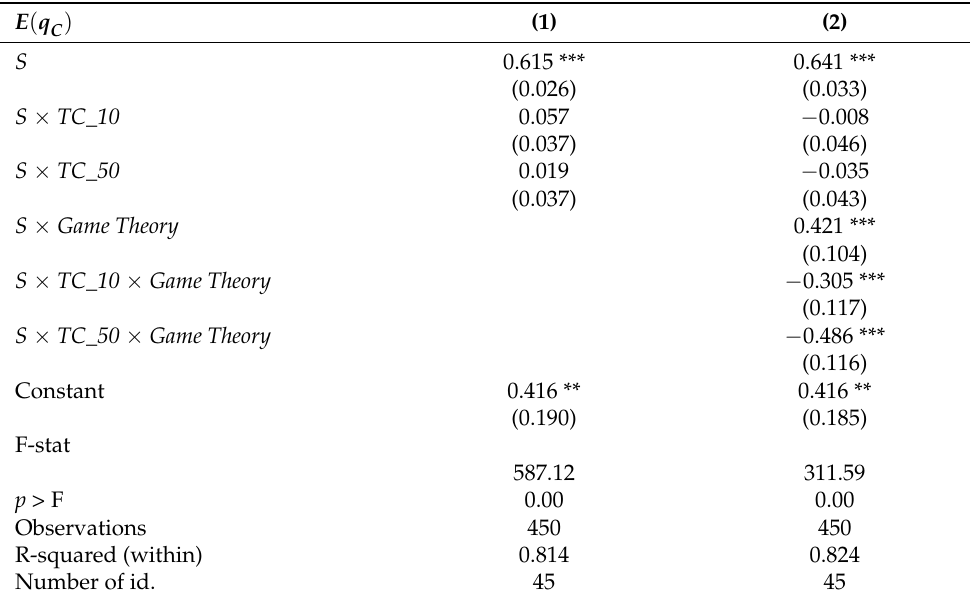
Table 2. Trustor’s expectations of the withdrawal of the third